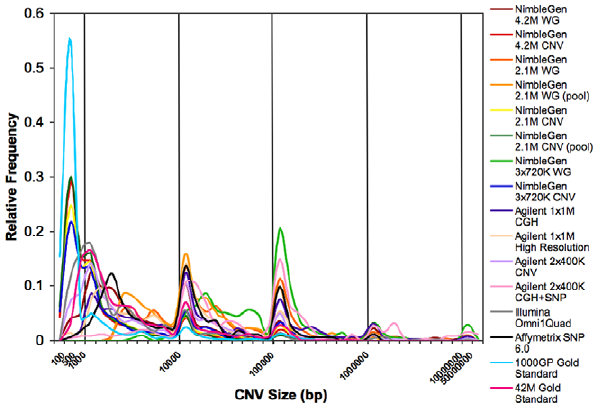
Figure 2. Size distributions of CNV call sets. Data include CNVs from all replicates of the fourteen different experiments listed in table 1 (twelve different platforms and two different conditions for NimbleGen 2.1 M arrays). The size distributions of the two Gold Standards are overlaid for reference. The apparent frequency spikes are results of the changing bin